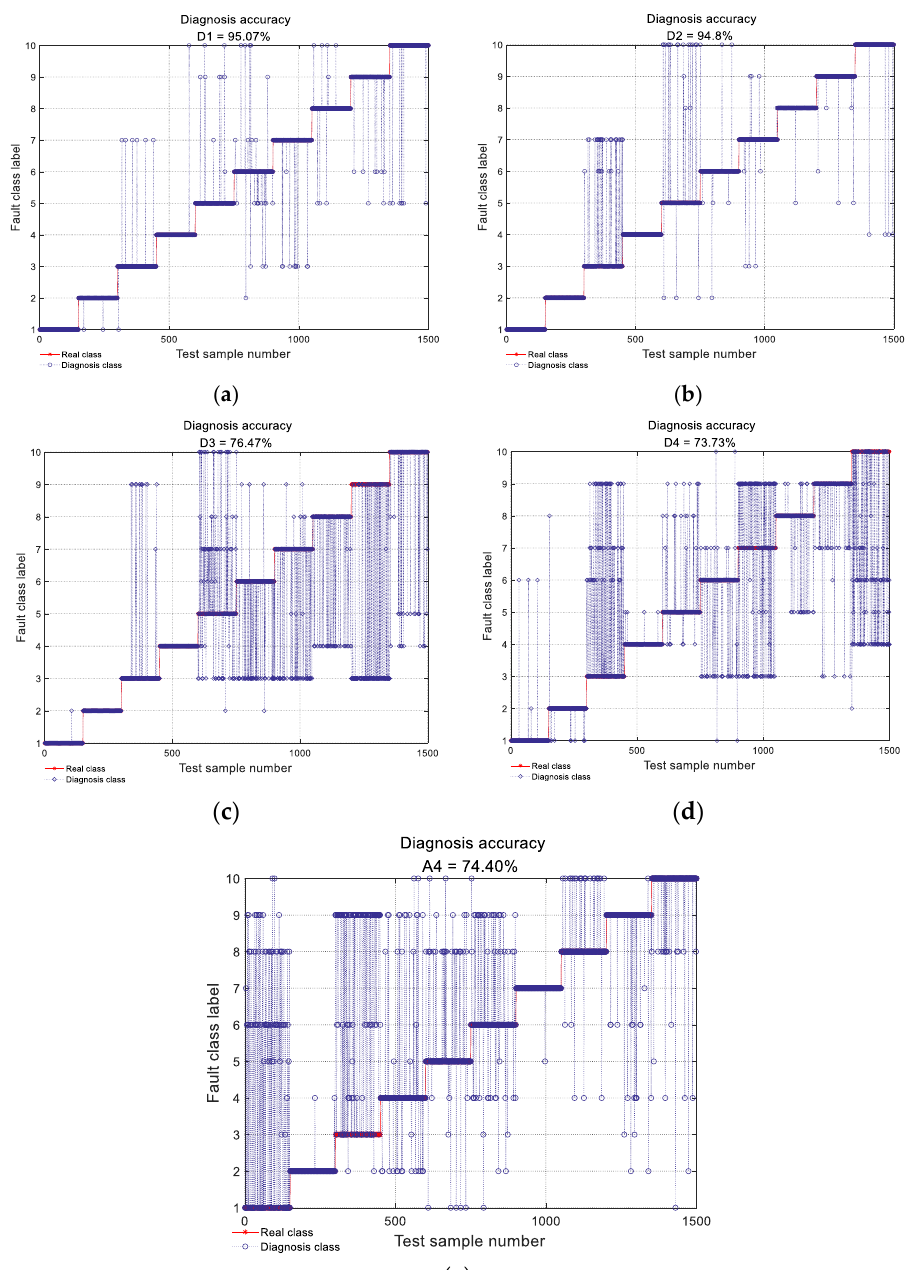
Figure 12. Diagnosis results of an individual ViT with different detail and approximation subsignal TFR. ( a – e ) Diagnostic accuracy with an individual ViT with D1, D2, D3, D4 and A4 subsignal TFR, respectively.